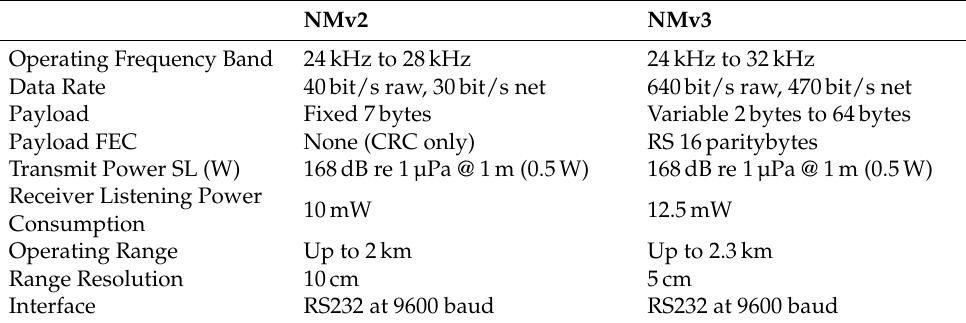
Table 6. NMv2 and NMv3 characteristics and